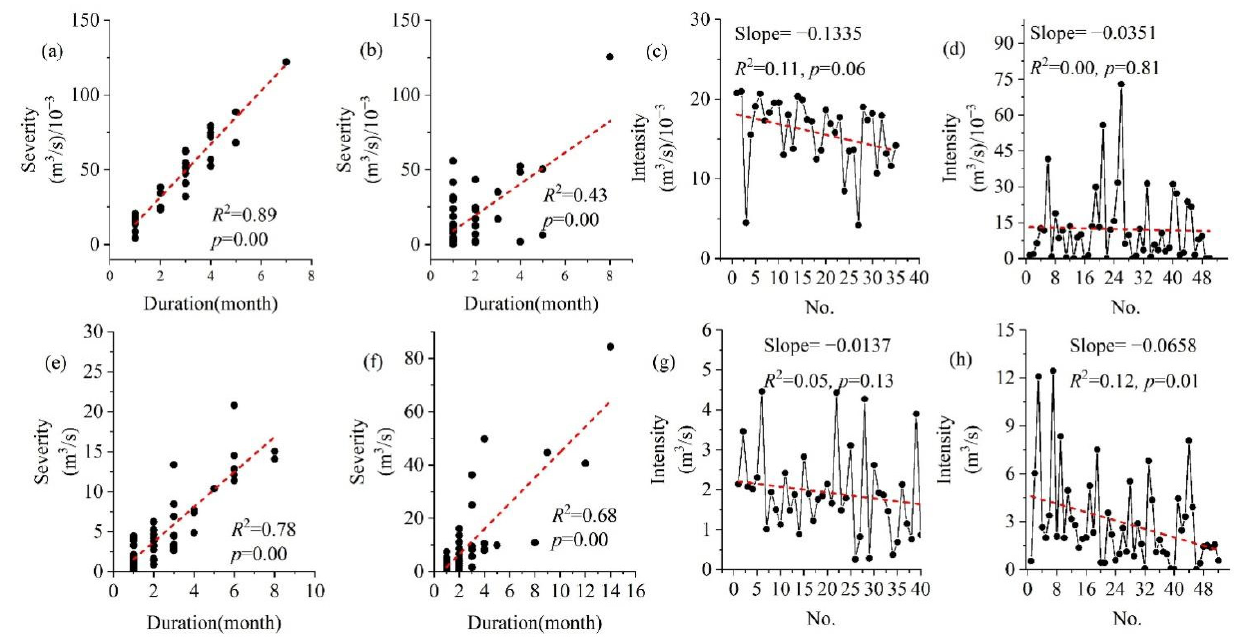
Figure 7. The relationship between the duration and severity of hydrological drought ( HD ) events at the HP0 station of the Harp Lake catchment ( a – d ) and Dongjiang River catchment ( e – h ) based on a fixed drought threshold ( a ) and ( e ) and variable drought threshold ( b ) and ( f ) methods; the linear change trend for the HD intensity identified using a fixed drought threshold ( c ) and ( g ) and variable drought threshold ( d ) and ( h ), respectively.